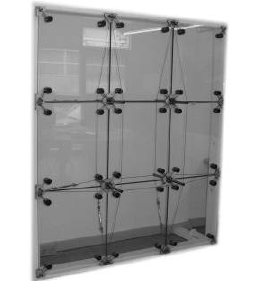
Figure 5 Experimental model of glass. Structural glass panels 1989.